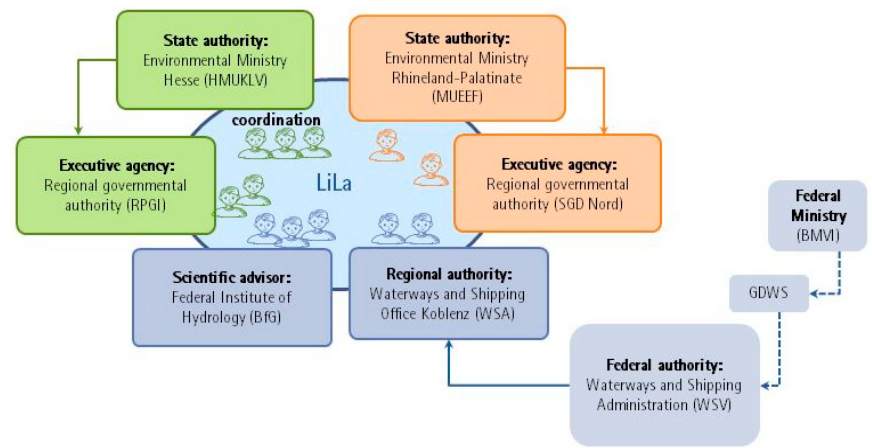
Figure 3. Overview of stakeholders considered in the case study, including hierarchical structures outside of the project.